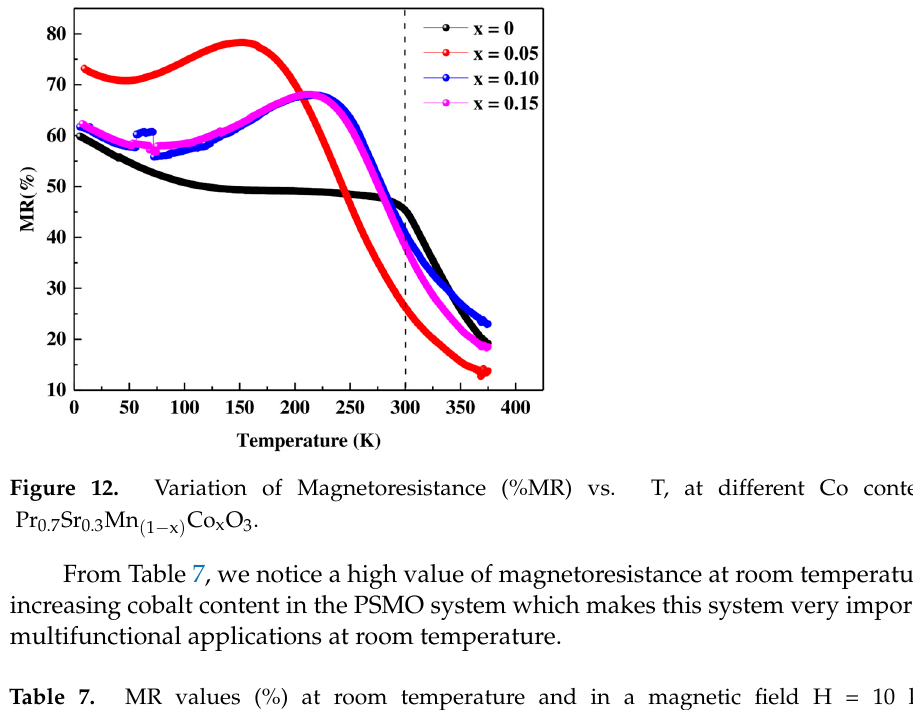
Figure 11. Magnetoresistance (%MR) vs. applied field at different temperature for